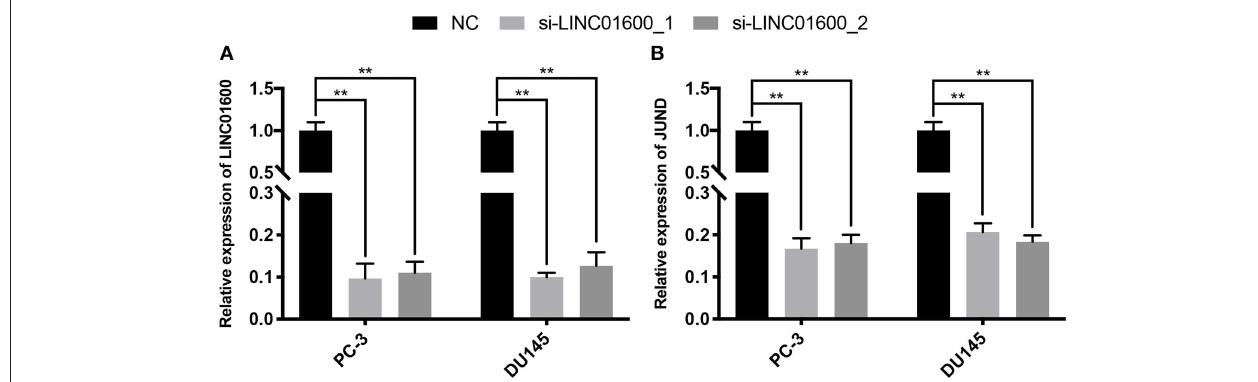
FIGURE 7 | The expression of LINC01600 and JUND in PC-3 and DU145 cell lines is detected by RT-qPCR. After downregulating (A) the expression of LINC01600 by si-LINC01600_1 and si-LINC01600_2, respectively and (B) the mRNA expression of JUND is also downregulated (** P < 0.01).